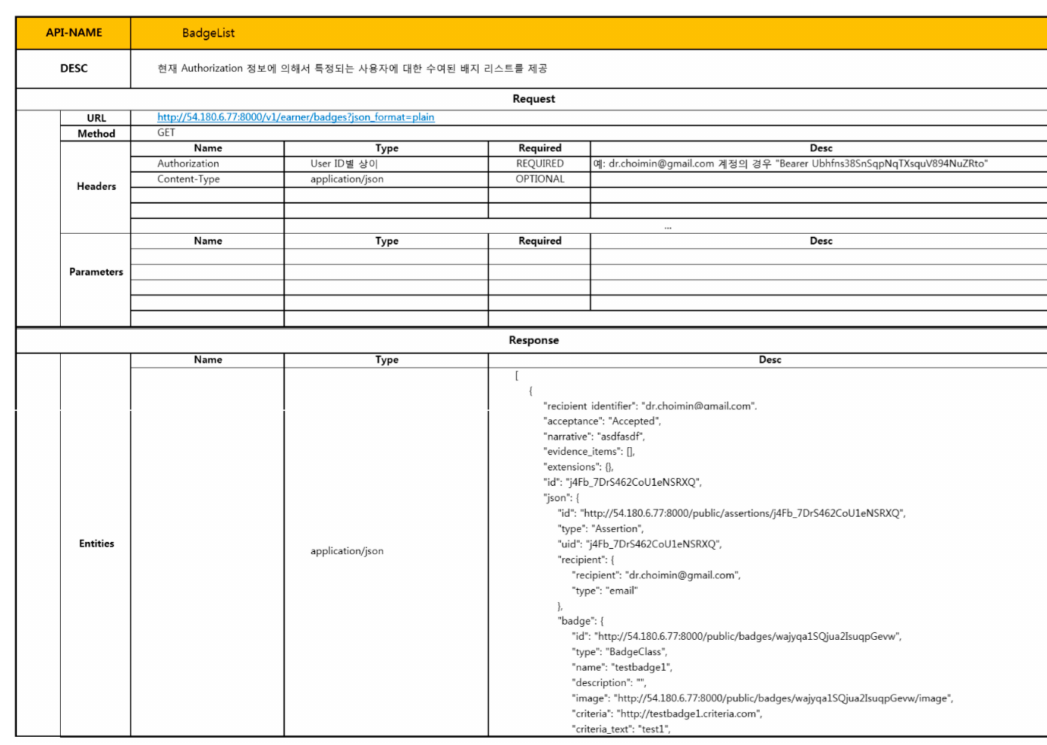
Figure 13. REST API for listing badges.